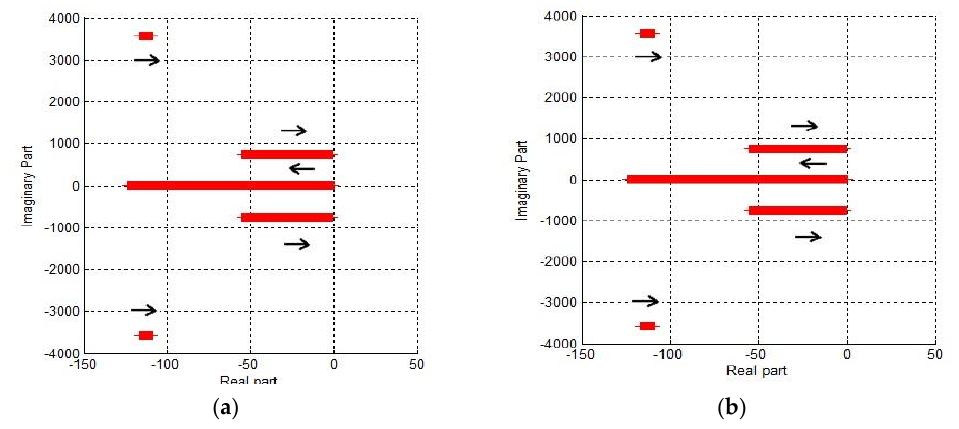
Figure 5. Root locus plot of closed loop characteristics equation. ( a ) 0 < K i ≤ 19, K p = 0.01; ( b ) 0 < K i ≤ 26, K p = 0.1.